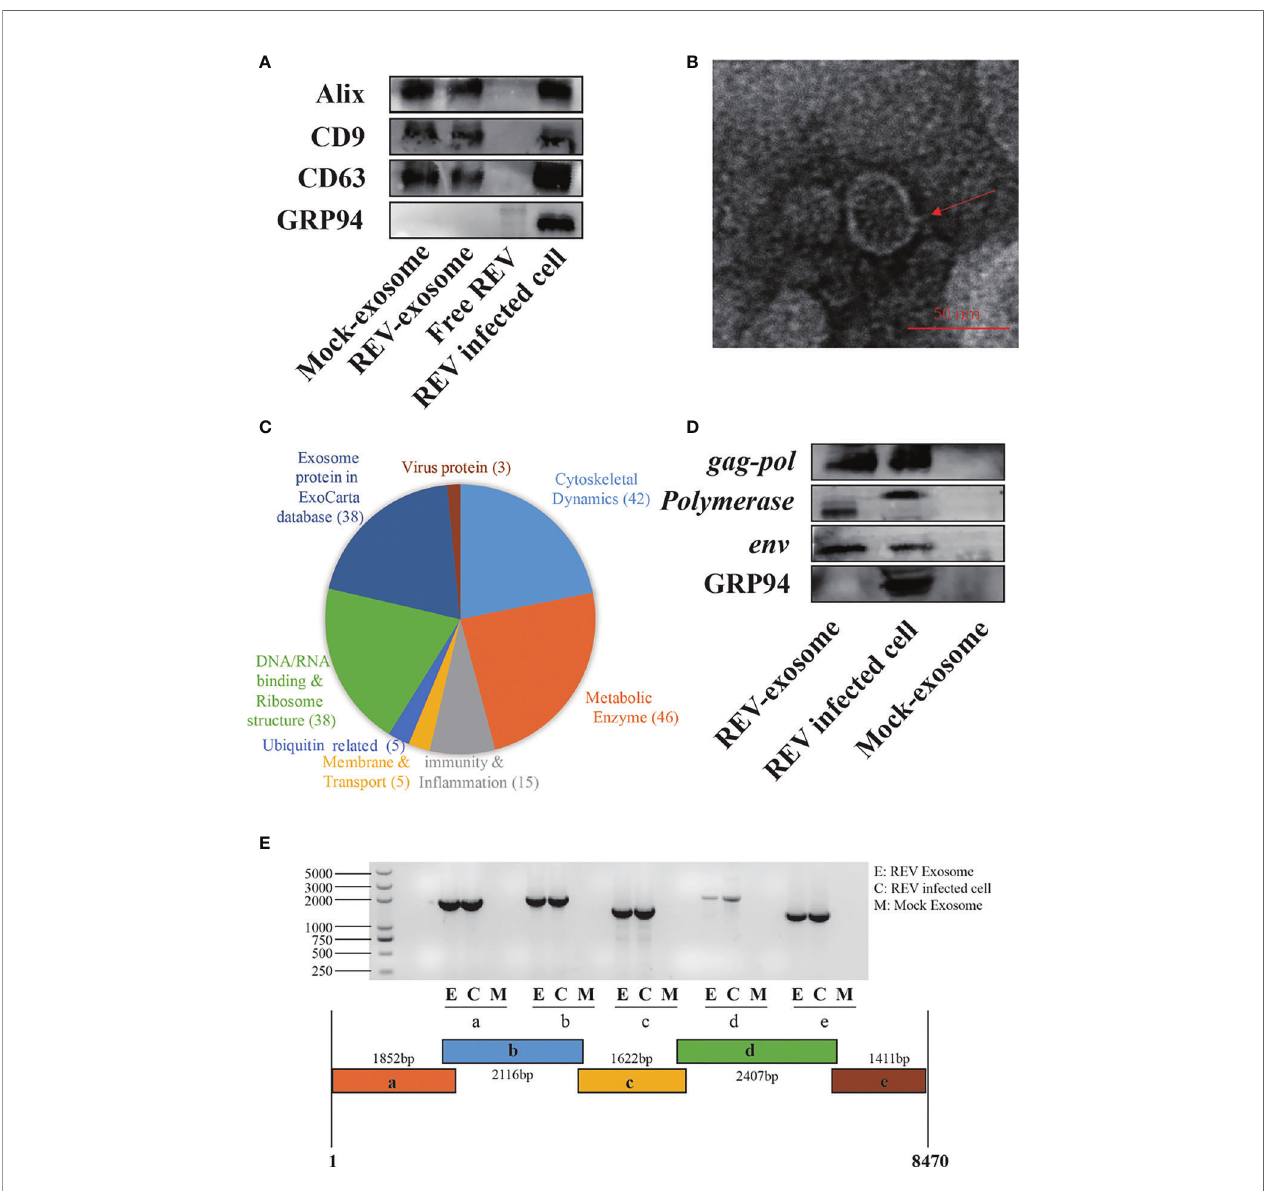
FIGURE 1 | Isolation, characterization, and components analysis of exosomes derived from reticuloendotheliosis virus (REV)-positive cock semen. (A) Puri fi ed exosomes derived from mock- or REV-positive cock semen were analyzed on Western blots probed with antibody against Alix, CD9, CD63, and GRP94. Puri fi ed REV virions (free REV) and the REV-infected cell were used as controls. (B) Transmission electron microscopy observations of negatively stained puri fi ed exosomes from REV-positive cock semen; scale bar = 50 µm. (C) LC-MS/MS analysis of the puri fi ed exosome from REV-positive cock semen, classi fi cation of host proteins according to function if included. (D) REV proteins in exosomes were con fi rmed on Western blots probed with antibody directed against env, gag, and pol. (E) REV genomic RNAs in puri fi ed exosomes isolated from REV-positive cock semen were detected with RT-PCR. Five overlapping fragments were designed based on the genome sequence of REV strain